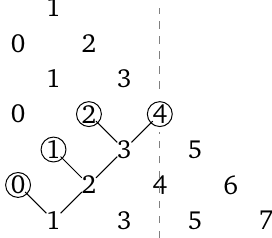
Figure 4: Recursive process for b